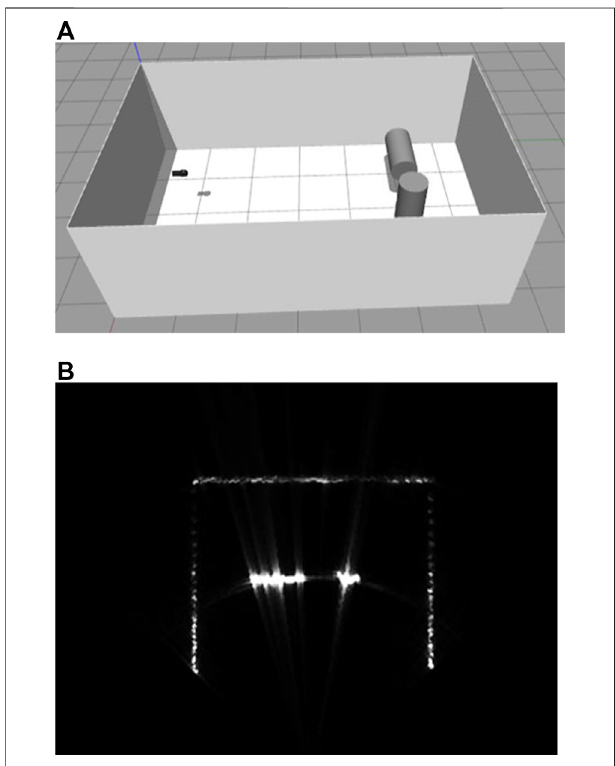
FIGURE 10 | Simulated multibeam echosounder image of two cylinder targets [ (A) simulation environment, (B) live-view sonar image].